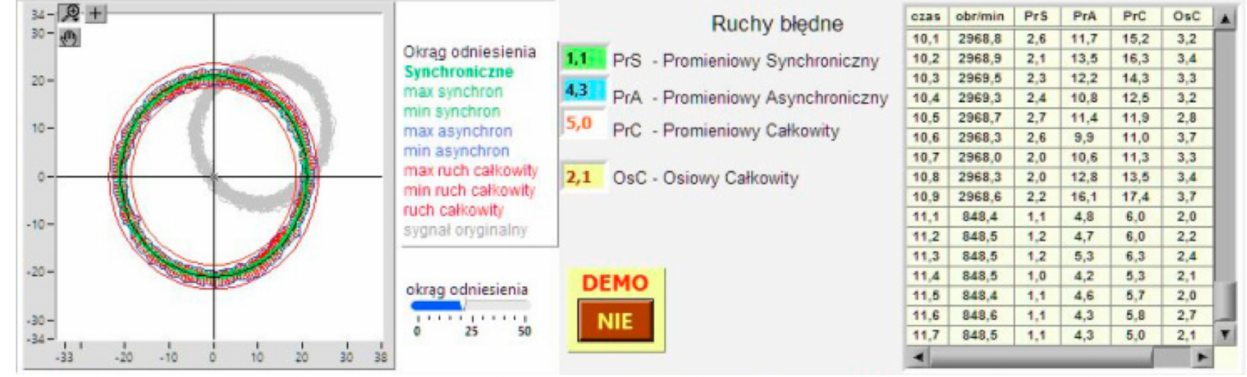
Figure 69. An example of a spindle error movements analysis chart.